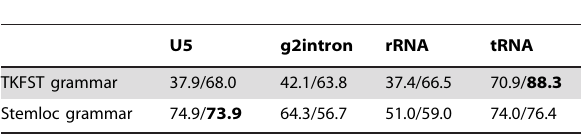
Table 6. Percentage sensitivity and positive predictive value (Sensitivity/PPV) for predicted base-pairs in the BRalibaseII benchmark.